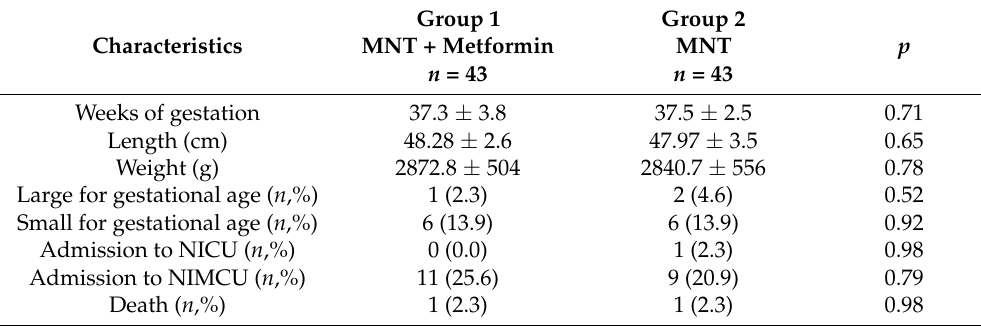
Table 7. Newborn outcomes of Mexican women who received intensive MNT plus metformin versus only intensive MNT.